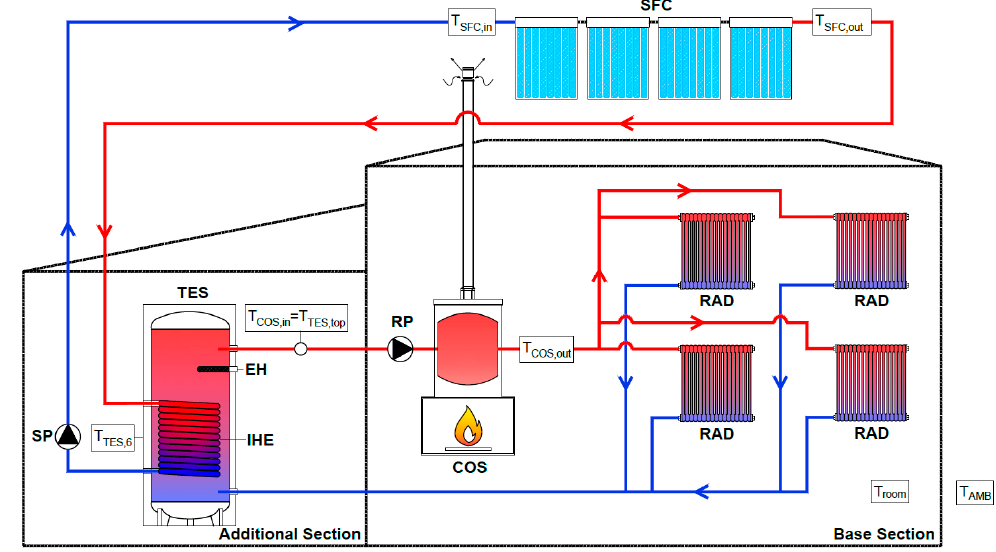
Figure 1. Schematic of the proposed plant.